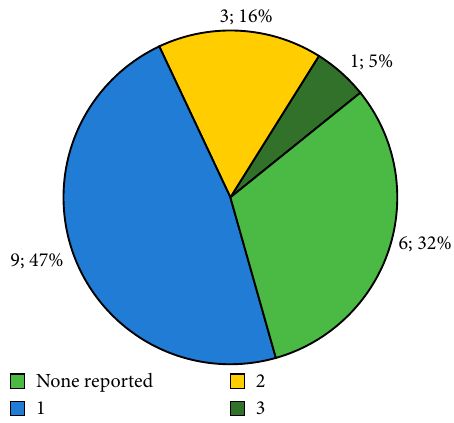
Figure 3: Number of associated pathologies per